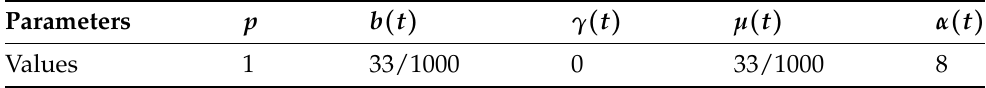
Table 5. Parameters for generating synthetic prevalence